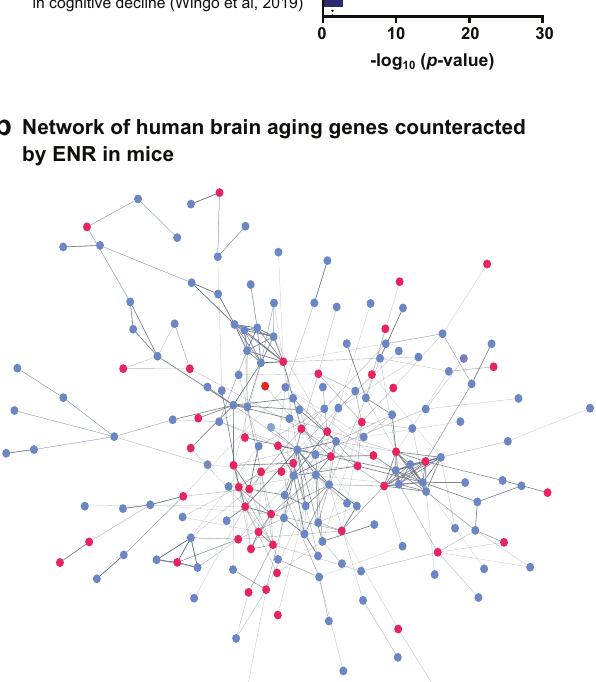
Fig. 6 Genes at which ENR counteracts age-related methylation changes are dysregulated in the human brain in age-related cognitive decline. a Genes with DNA methylation changes 38 , differential RNA 65 , or protein 66 levels in the human prefrontal cortex associated with age-related cognitive decline are signi fi cantly enriched among the genes that are differentially methylated with aging and 1 year ENR in the mouse dentate gyrus. For overlap with differentially methylated genes 38 , direction of the DNA methylation changes was taken into account. For differentially expressed genes and differential proteins, genes were overlapped independent of the direction of the age-related DNA methylation changes. Depicted are the − log p -values) from one-sided hypergeometric tests and the number of 10 ( genes that overlapped between datasets. The dashed line indicates a signi fi cance threshold of p = 0.05. b STRING protein interaction network of human brain aging genes at which ENR counteracted age-related DNA methylation changes in the mouse brain. Genes involved in the highest enriched GO biological process “ neurogenesis ” are highlighted in